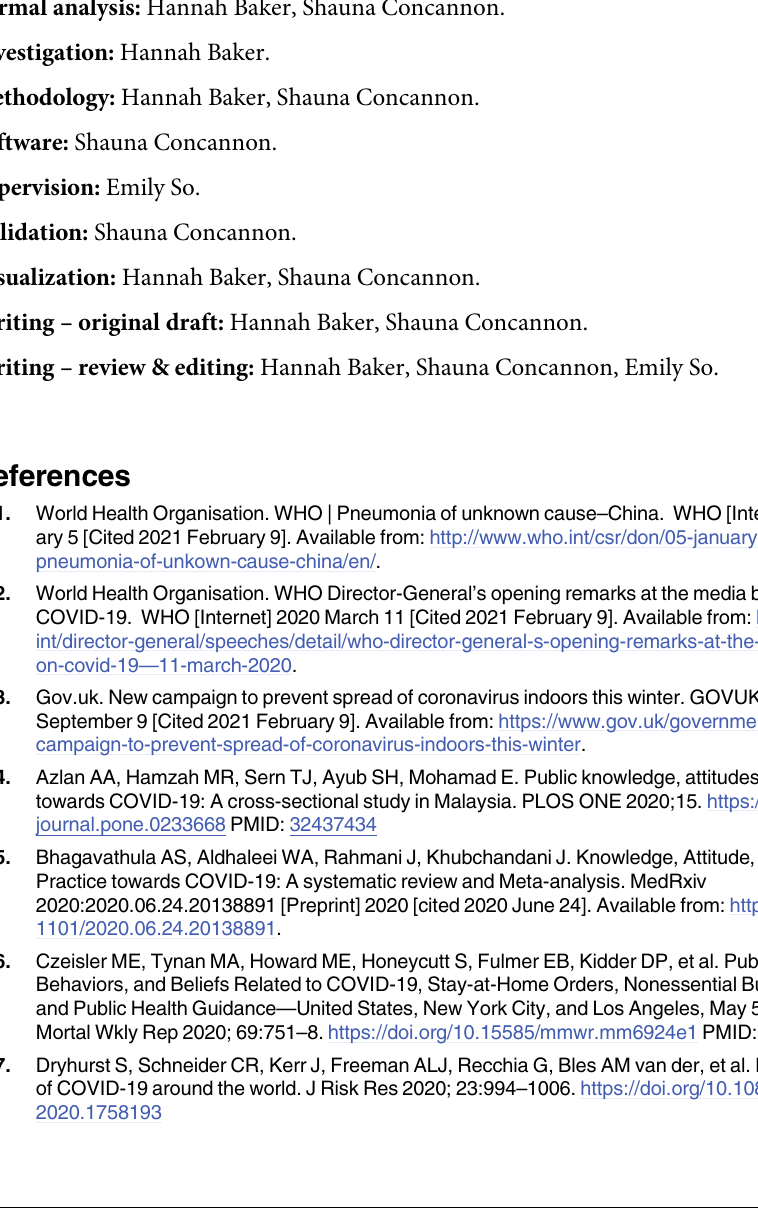
S3 Appendix. Inter-annotator agreement. Sheets/tabs show the method to calculate the inter-annotator agreement discussed in the paper’s methodology and limitation